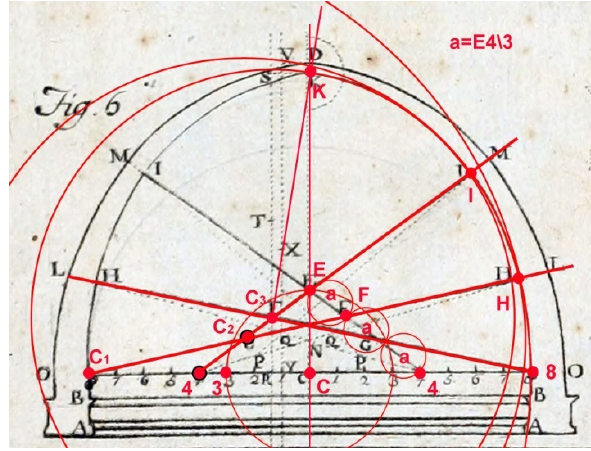
Figure 3. B. A. Vittone, Regole per il dimensionamento geometrico delle cupole ( Istruzioni elementari per l'indirizzo dei giovani allo studio dell'architettura, 1760